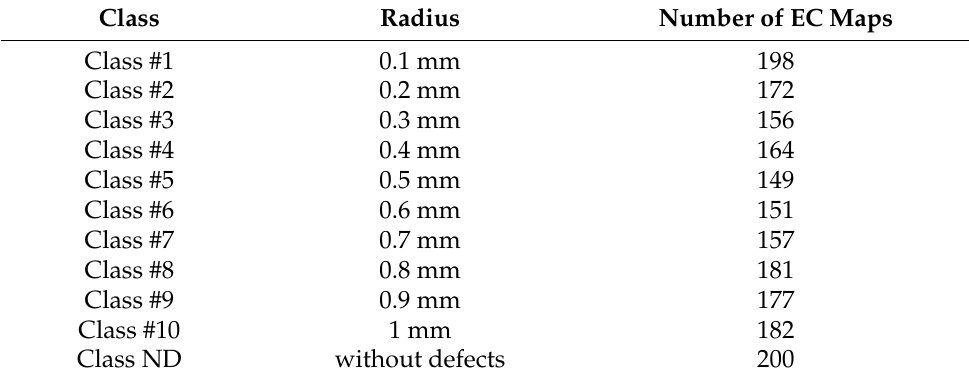
Table 3. Characteristics of the classes of defects obtained by the campaign of